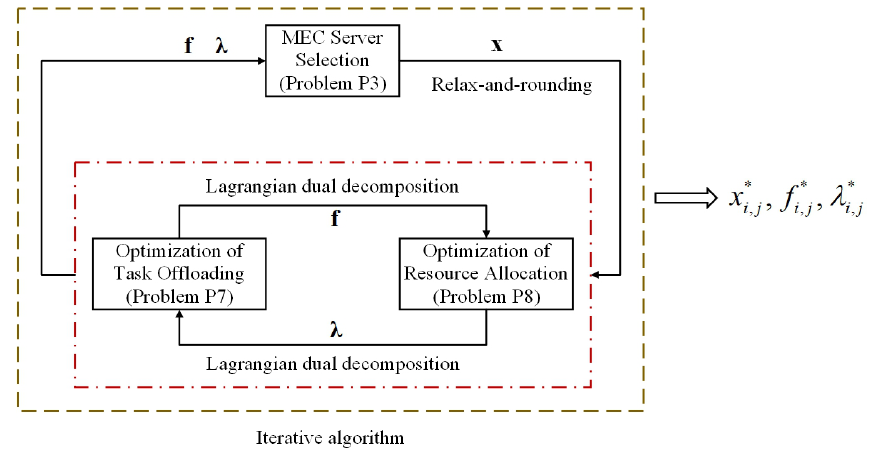
Figure 4. General architecture of the proposed